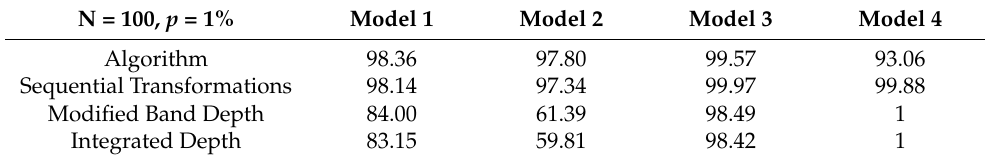
Table 3. Average ranking of the outlier curve across the 100 replications of the experiments for the selected models. The Sequential transformations procedure is presented in [35]. The Modified Band Depth is presented in [36], and the standard Integrated Depth appears in [41]. In this case, the closer the value of a method is to 100, the more outlying it will be according to the corresponding ranking measure. N = 100, p =